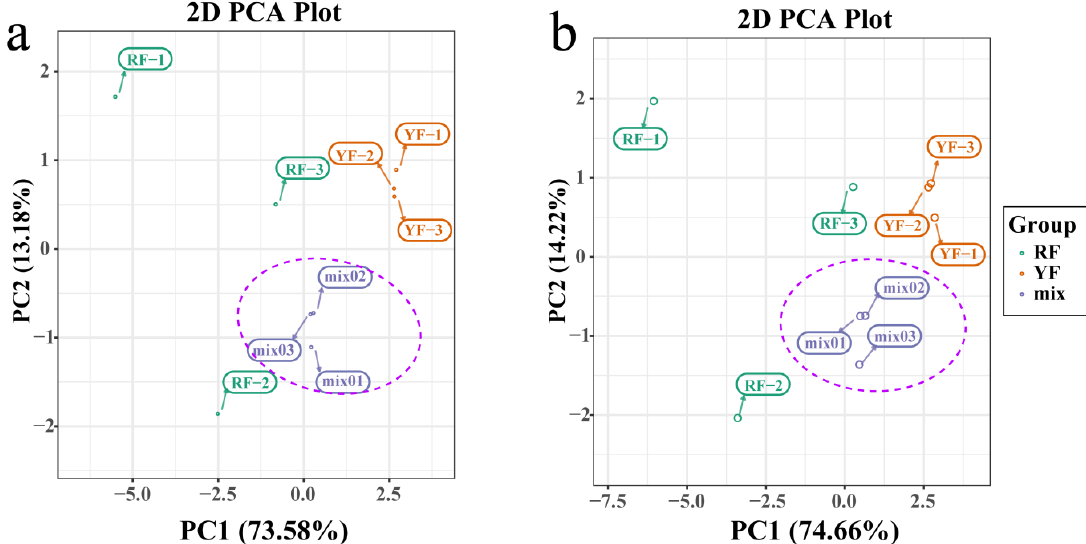
Figure 1. Differential anthocyanin metabolite analysis based on principal component analysis (PCA). ( a ) Principal component analysis (PCA) score plot derived from metabolite ions acquired using the electrospray ionization positive ion mode (ESI + ). ( b ) PCA score plot derived from metabolite ions acquired using the electrospray ionization negative ion mode (ESI - ).